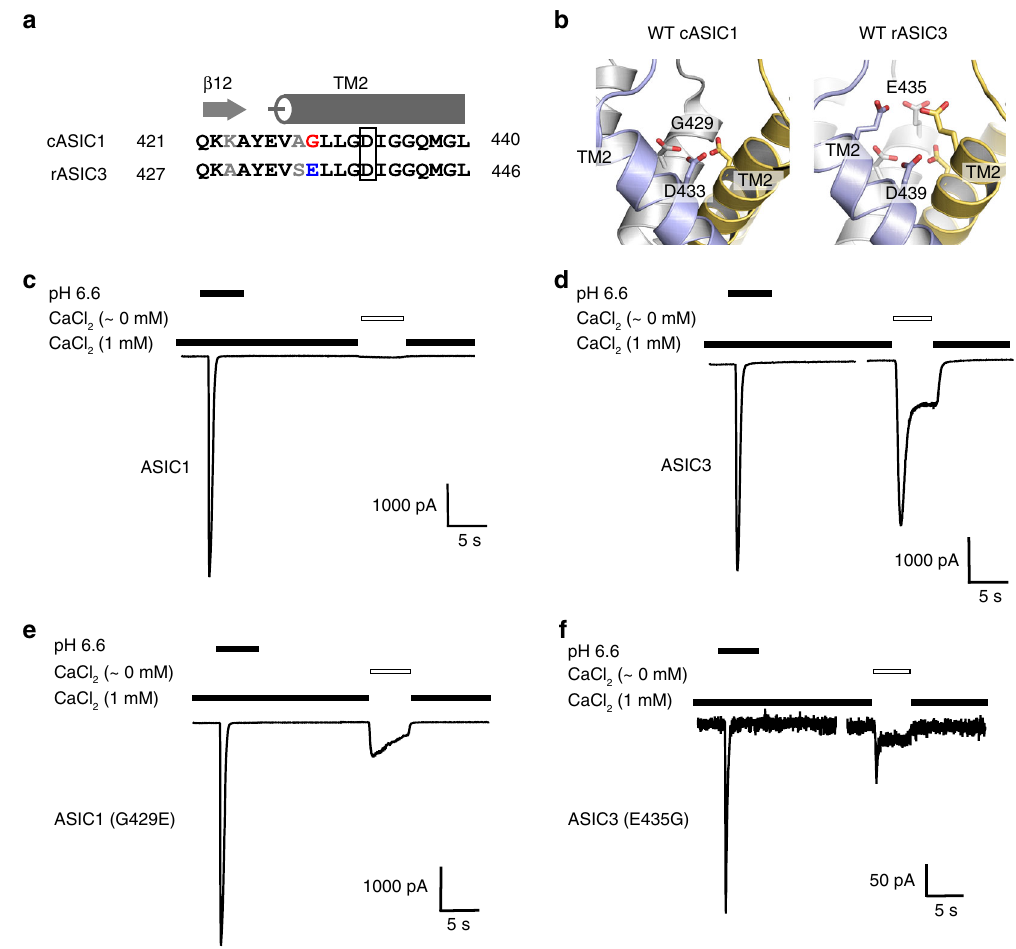
Fig. 1 Mutation at the pore of ASIC3 mediates relief of Ca 2 + block. a Sequence alignment of the β 12 sheet and TM2 domains of cASIC1 and rASIC3. Residues that differ between these subtypes are shown in gray. The residues that contribute to the Ca 2 + block site and studied in this report are highlight in red and blue. b cASIC1 (left) and modeled rASIC3 (right) protein gate regions are shown. rASIC3 was generated using the desensitized cASIC1 crystal structure (PDB code: 4NYK) as a backbone. In rASIC3, there is potential for six acidic residues that face the pore entrance. c – f Representative whole-cell patch-clamp electrophysiology recordings of cASIC1, rASIC3, cASIC1 G429E, and rASIC3 E435G are ( V hold = − 70 mV). Test solutions were administered for 5 s before returning to normal external solution. ASIC subtype activation was achieve using pH 6.6 and 1 mM CaCl 2 activating solution and moderate activation with nominal CaCl 2 (~0 mM, open bar) concentrations in the conditioning pH 7.4. Scale bars are in picoAmperes (pA) and seconds (s). Percent of pH 6.6 peak current amplitude are summarized for cASIC1 (2.8 ± 1.1%, n = 13), cASIC1 (G429E) (13 ± 1.1%, n = 8), rASIC3 (73 ± 3.1%, n = 11), and rASIC3 (E435G) (28 ± 5.6%, n = 6). The current from cASIC1 G429E ( p = 0.0008) and rASIC3 E435G ( p = 0.00007) were signi fi cantly different from the respective wild-type controls. Error bars are s.e.m.